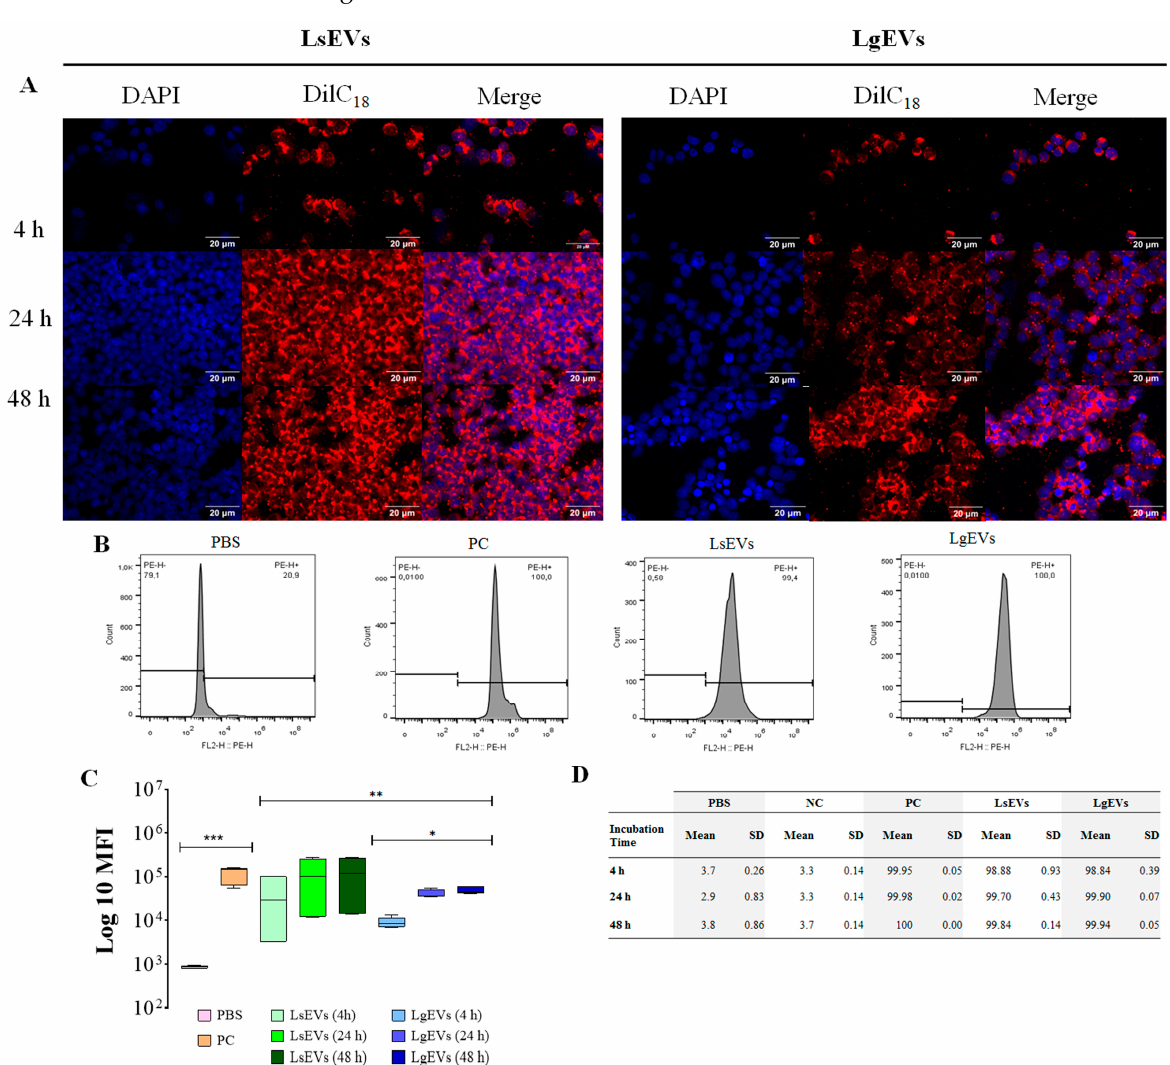
Figure 5. Macrophage incorporation of L. shawi and L. guyanensis EVs. EVs of L. shawi (LsEVs) and L. guyanensis (LgEVs) were isolated, stained with DilC 18 , purified with exosome spin columns (MW3000, Invitrogen, USA), and incubated with M Φ for 4 h, 24 h, and 48 h. Fluorescence microscope images of M Φ stained with DAPI (blue) and incubated with DilC 18 (red) labeled EVs were acquired (600 × magnification) ( A ). DilC 18 positive cells were analyzed by multiparametric flow cytometry, and median fluorescence intensity (MFI) ( B , C ) and the frequency of positive stained-M Φ were registered ( D ). Student’s parametric t -test was used for statistical analysis. * ( p < 0.05), ** ( p < 0.01) and *** ( p < 0.0001) indicate statistical significance. As the negative control (NC) of the assay, 1 × PBS was incubated with DilC 18 , purified through the column, and added to resting (non-stimulated) M Φ . For positive control (PC), DilC 18 was directly used to stain the membranes of resting M Φ